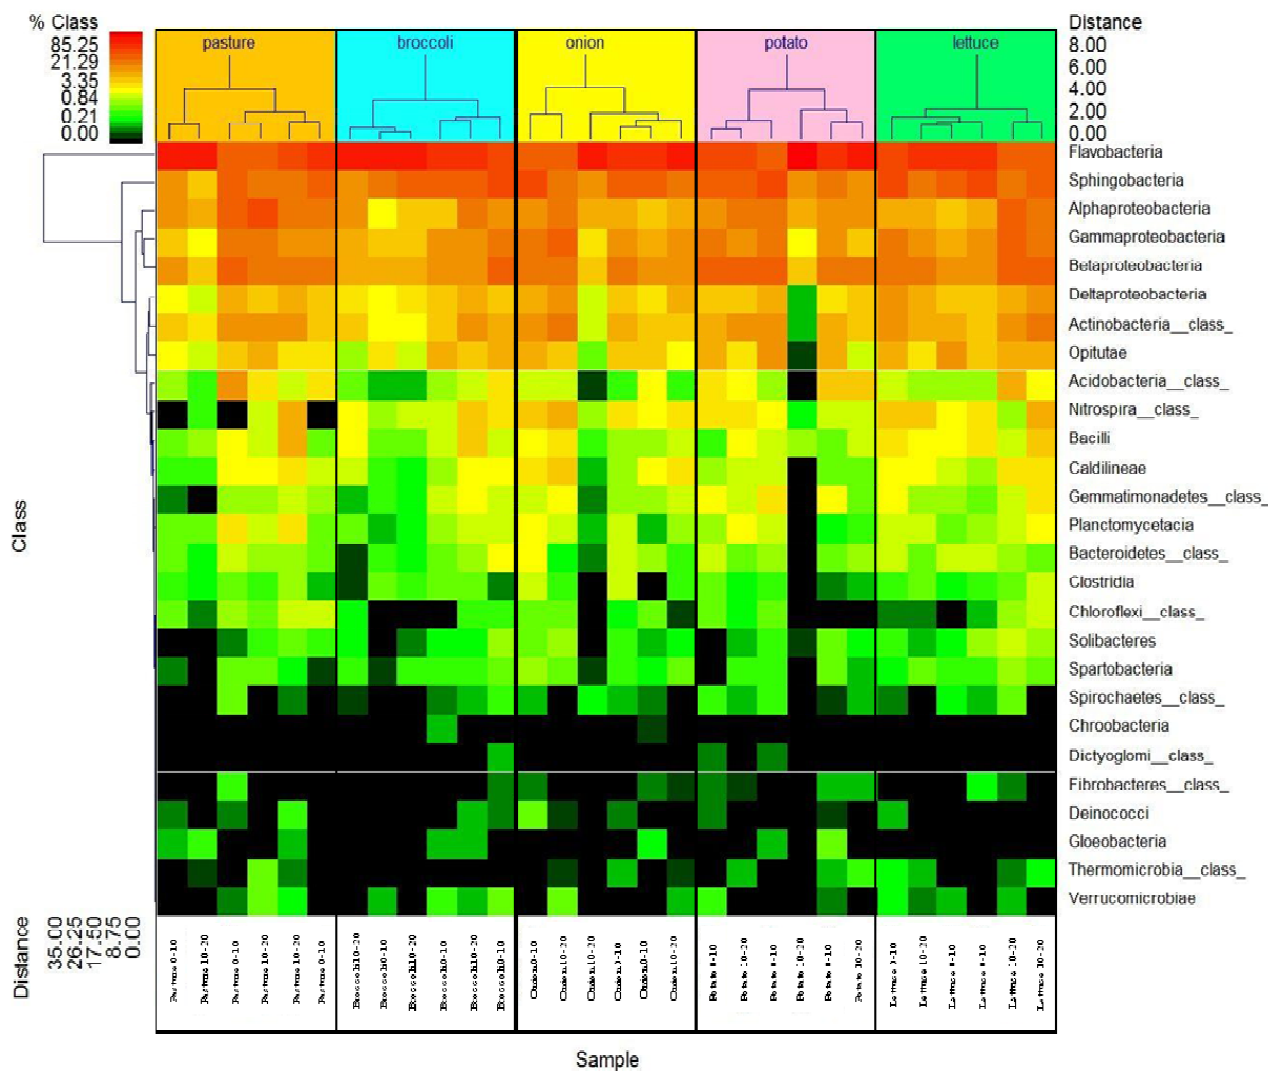
Figure 3. Double hierarchal dendogram to evaluate bacteria distribution in this soil as affected by the different rhizospheres in an organic production